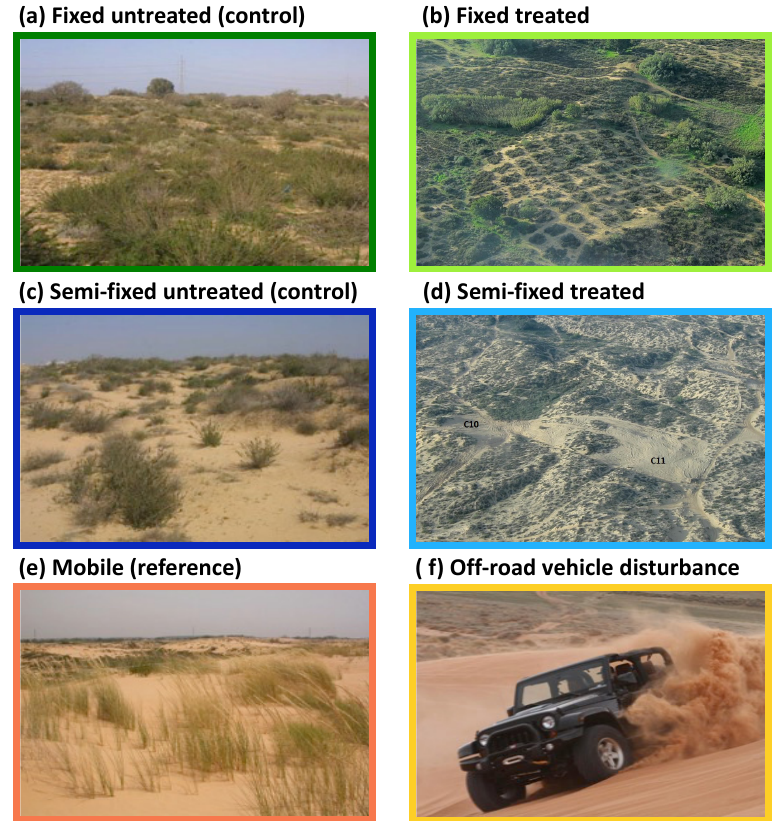
Figure 1. Dune treatments investigated in Nizzanim Long Term Ecological Research (LTER); ( a ) Fixed untreated (control) dune; ( b ) Fixed treated ( c ) Semi-fixed untreated (control); ( d ) Semi-fixed treated; ( e ) Mobile dune (reference) dune; ( f ) O ff -road vehicle disturbance. Semi-fixed and Fixed Treated dunes were paired with un-treated Semi-fixed and Fixed untreated control dunes respectively. All treated dunes were compared to their un-treated control pair and Mobile dunes as the restoration reference. Disturbed dunes were exposed to illegal, un-quantified o ff -road vehicle disturbance. They were compared to both Mobile and Semi-fixed untreated dunes to examine their relative composition. Frames of the di ff erent dune types shown are colour consistent throughout all